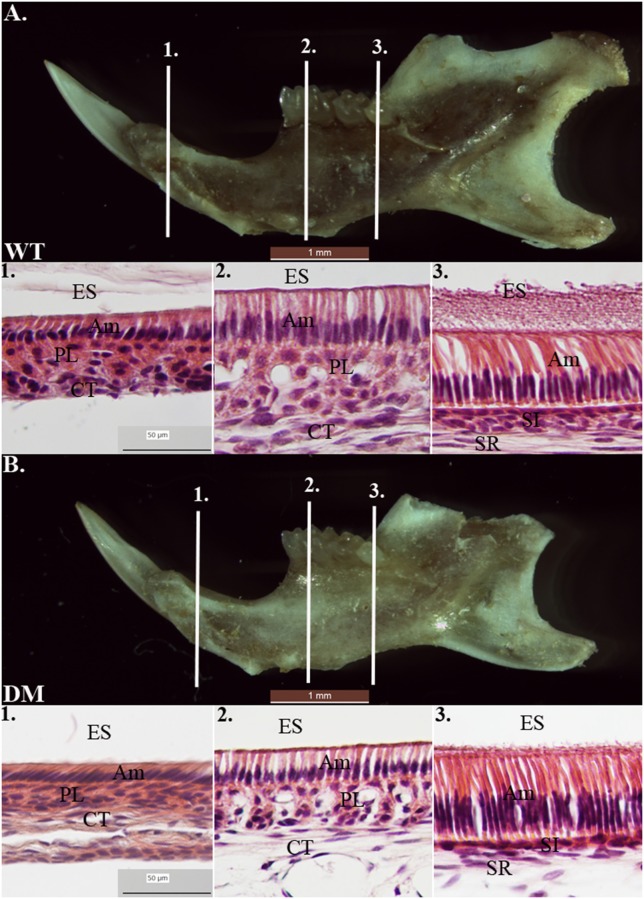
Histological analysis of wild-type and double-mutant enamel organs by H& E staining. WT, Wild-type; DM, Double-mutant; ES, Enamel space; Am, Ameloblast; PL, Papillary layer; CT, Connective tissue; SI, Stratum intermedium; SR, Stellate reticulum. (A1–A3) Wild-type enamel organ in late-maturation, maturation and secretory stages (labeled by three reference planes 1, 2, and 3). (B1–B3) Double-mutant enamel organ at the three reference planes. Magnification 40x. Compared to the wild-type group, cell morphology in double-mutant enamel organs in the same regions was not significantly different.